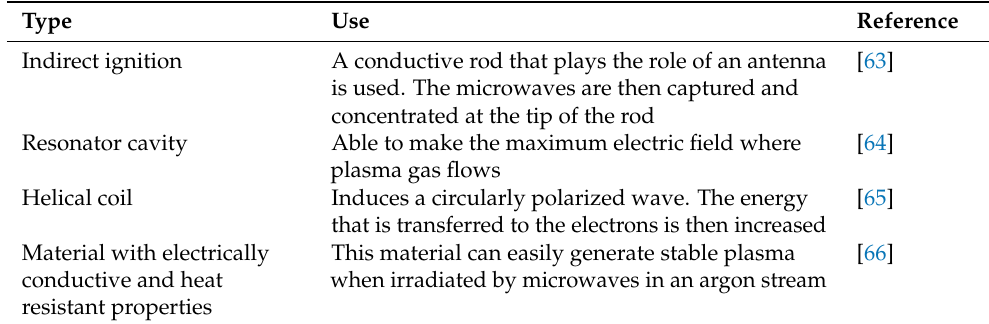
Table 2. Microwave induced plasma